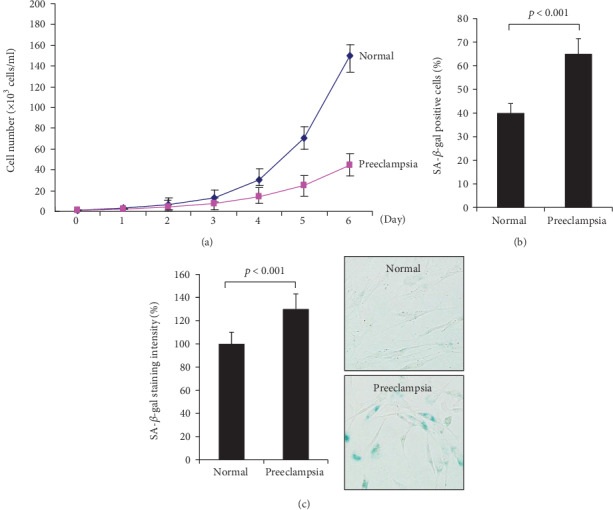
Increased senescence of hUCB-MSCs from women with preeclampsia. (a) Proliferation assay of hUCB-MSCs from the two groups. After 6 days, the number of cells was significantly lower in cultures of hUCB-MSCs derived from women with preeclampsia than in cultures of hUCB-MSCs derived from women with normal pregnancy. Data are the mean ± SD. (b) The number of SA-β-gal-positive cells was counted from at least 200 cells. The percentage of cells that were clearly SA-β-gal-positive was significantly higher in the preeclampsia group (n = 10) than in the normal group (n = 10). (c) The staining intensity of SA-β-gal-positive cells was determined by densitometry. The relative staining intensity was significantly higher in the preeclampsia group. Values are the mean ± SD. p < 0.001 by Mann-Whitney U test.